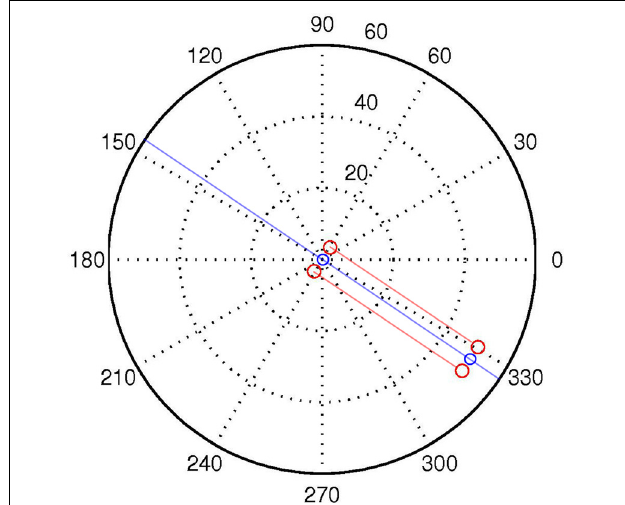
at”) the other agent at the origin. The red dots correspond to the positions of the sensors of each agent. The semi-transparent red lines correspond to the LoS of the central visual sensors for each “eye.” The semi-transparent blue line demarks the auditory midline, or line of equidistance from the two auditory sensors. This corresponds to the “beam” projected in beamforming. The blue circles represent the “mouth” of the